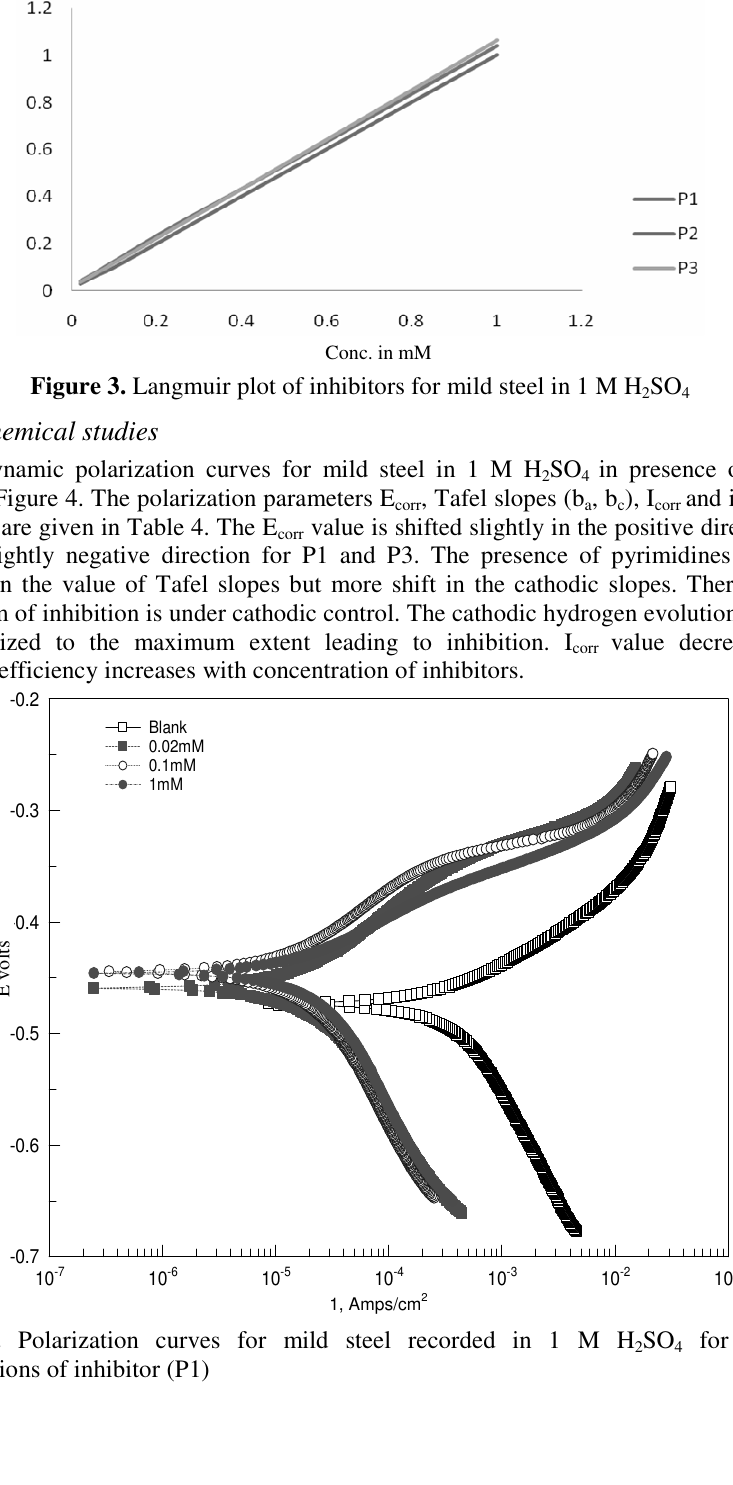
SO for selected 2 4